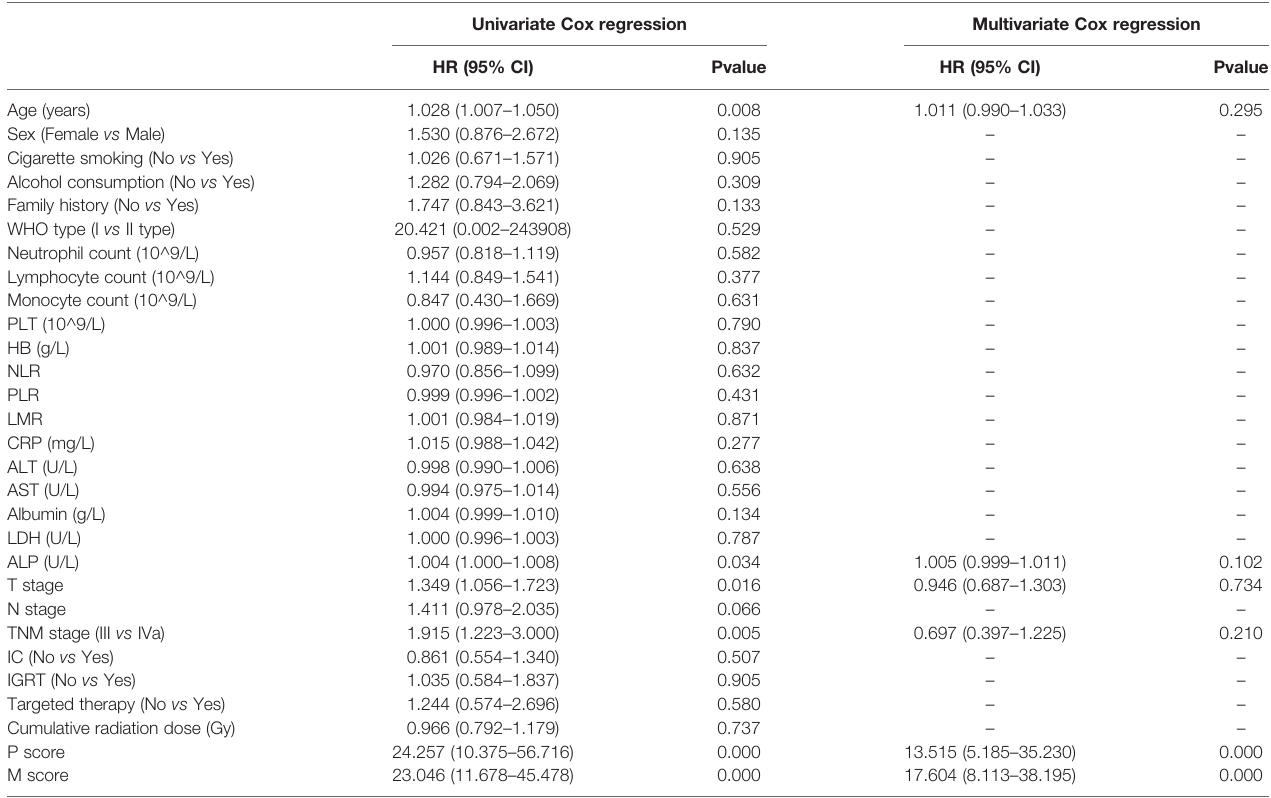
TABLE 2 | Identi fi cation of risk factors of PFS by univariate and multivariate Cox